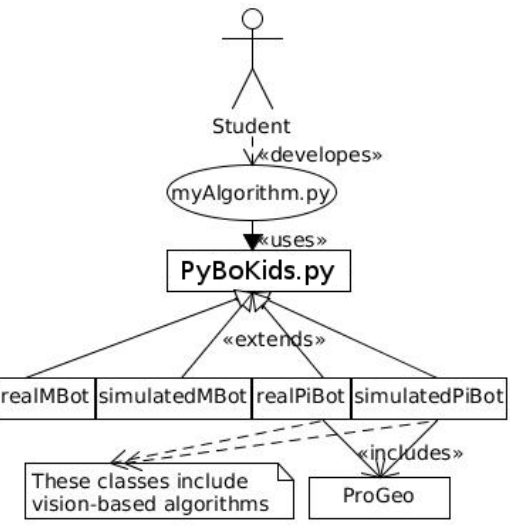
Figure 3. The student uses the PyBoKids.py library in his program.